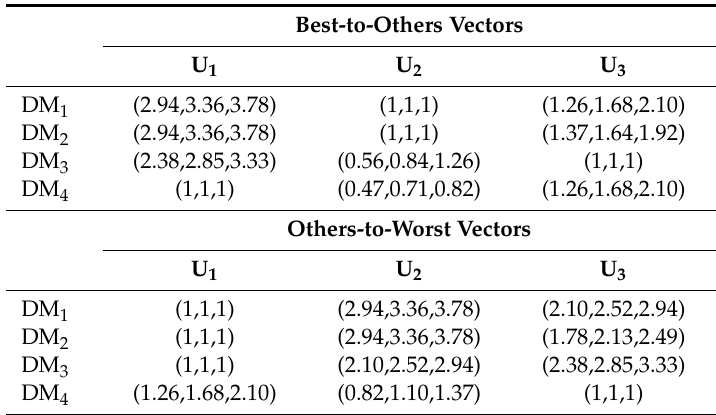
Table 9. The fuzzy preference comparison